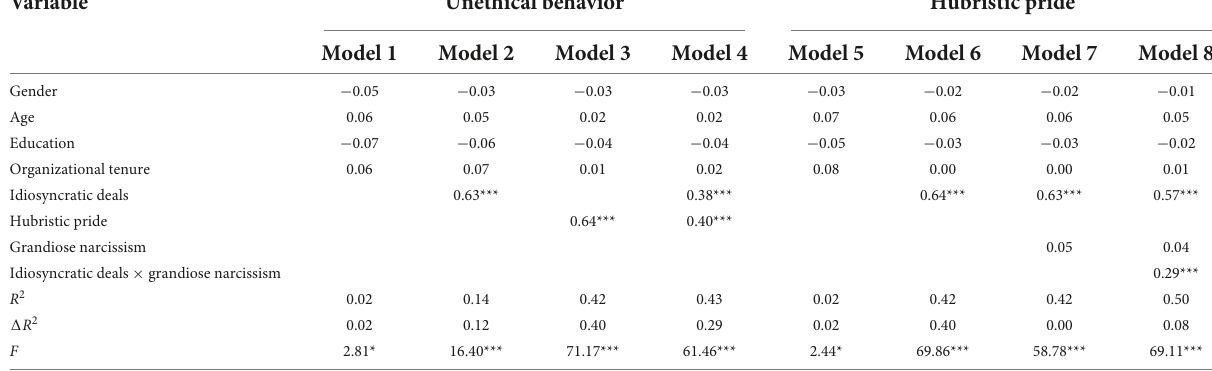
TABLE 5 Results of hierarchical regression analysis ( N = 492).